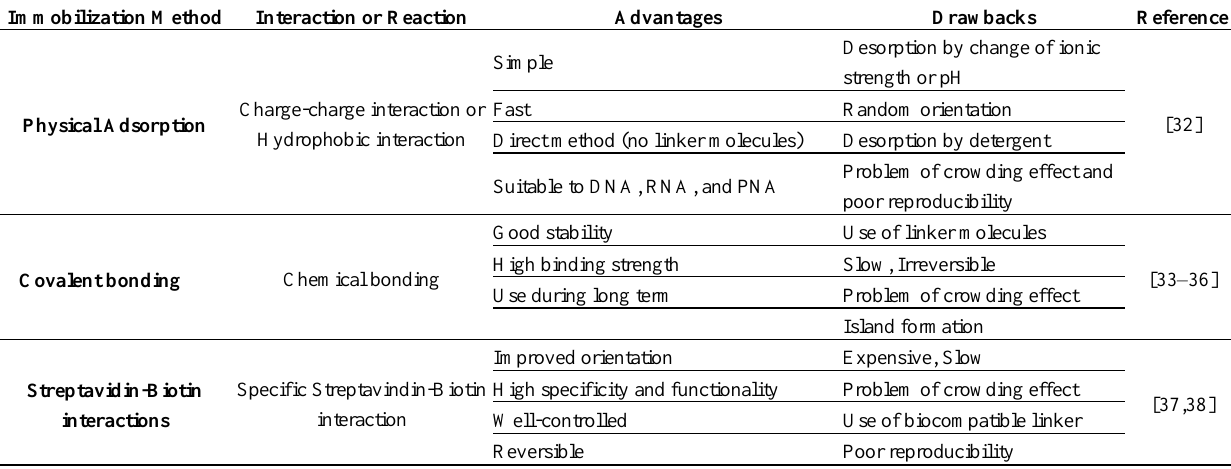
Table 1. Immobilization method of DNA probes on functionalized